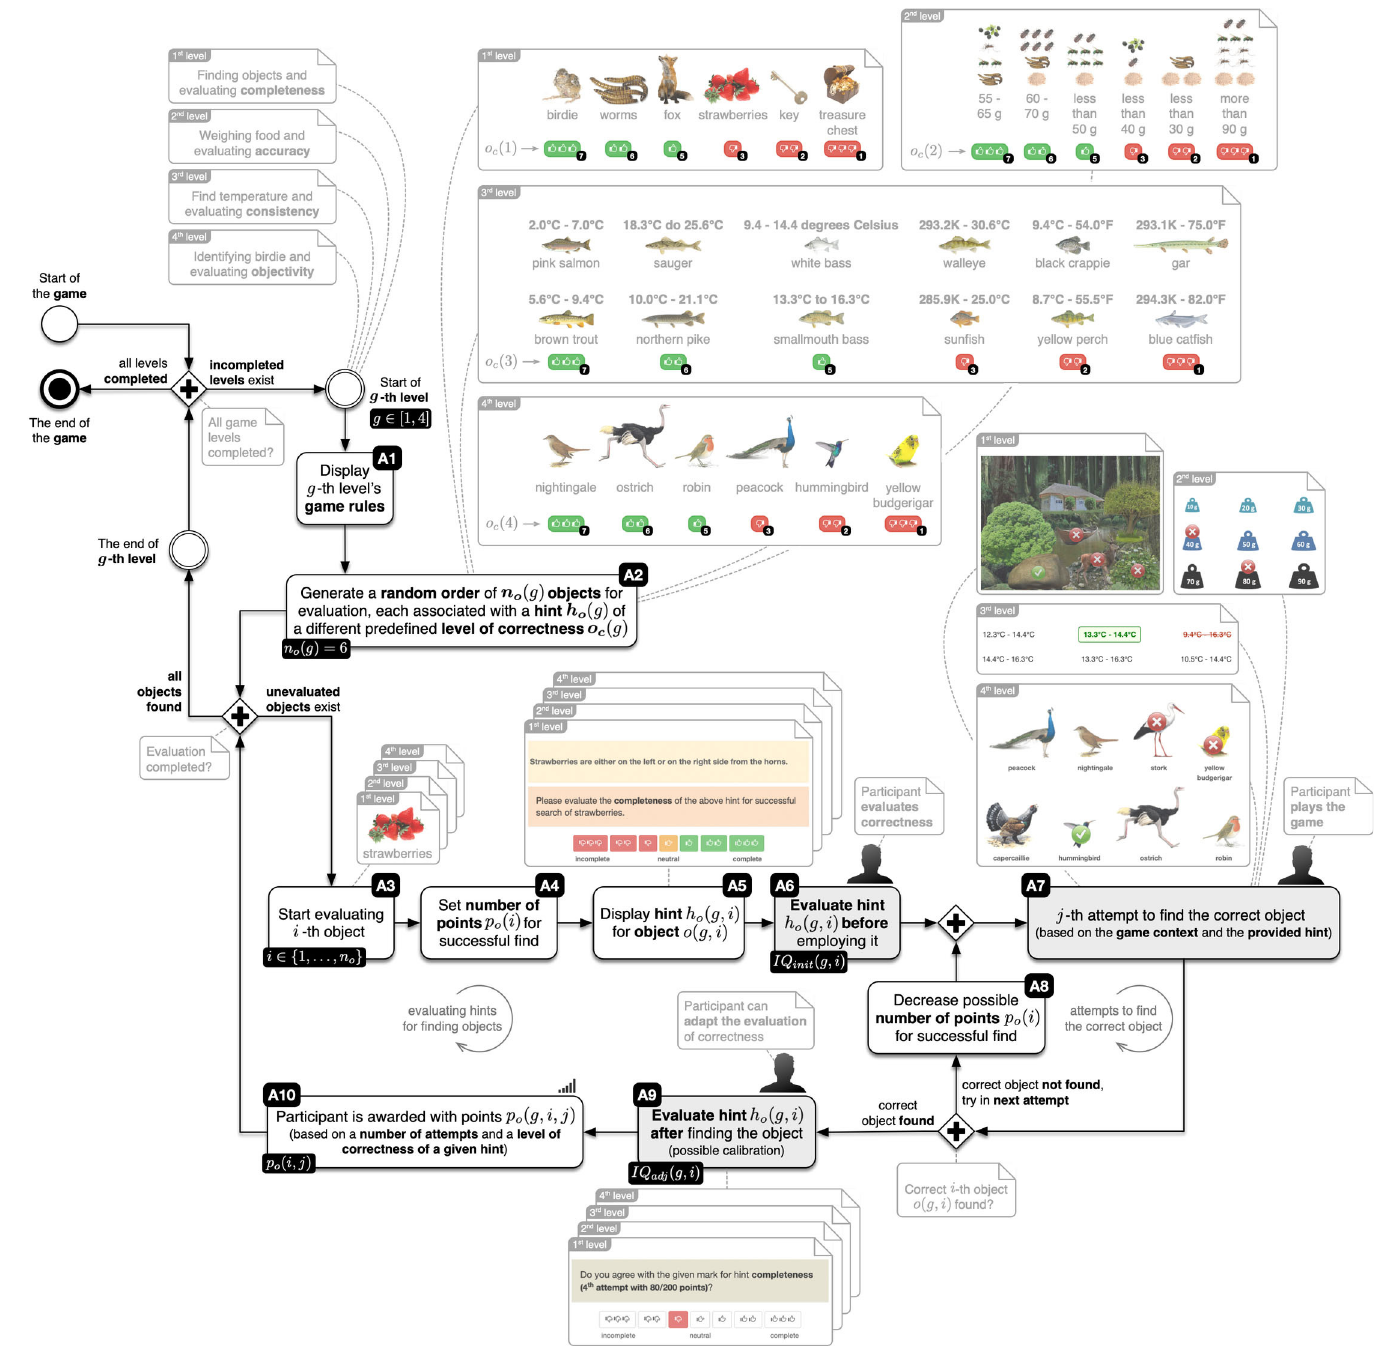
Fig 2. Detailed process of measuring selected IQ dimensions.